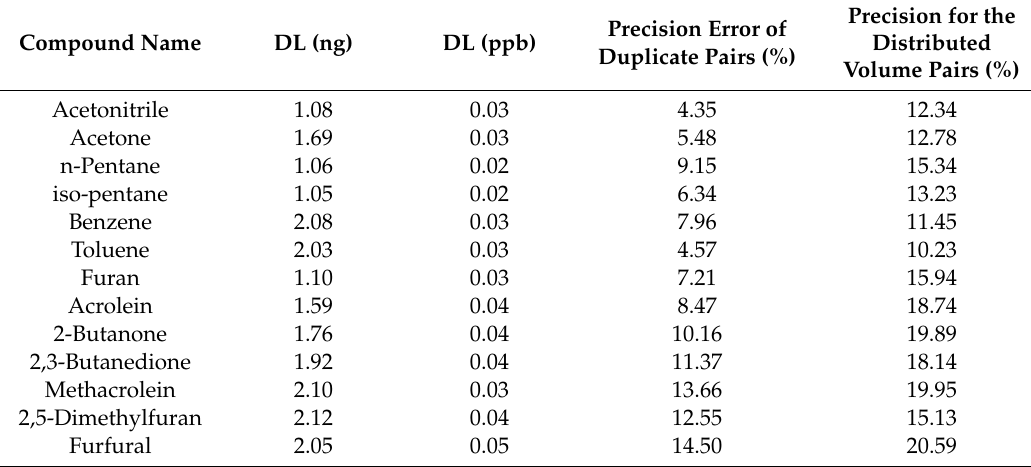
Carboxen-Graphsphere thermal desorption (TD)